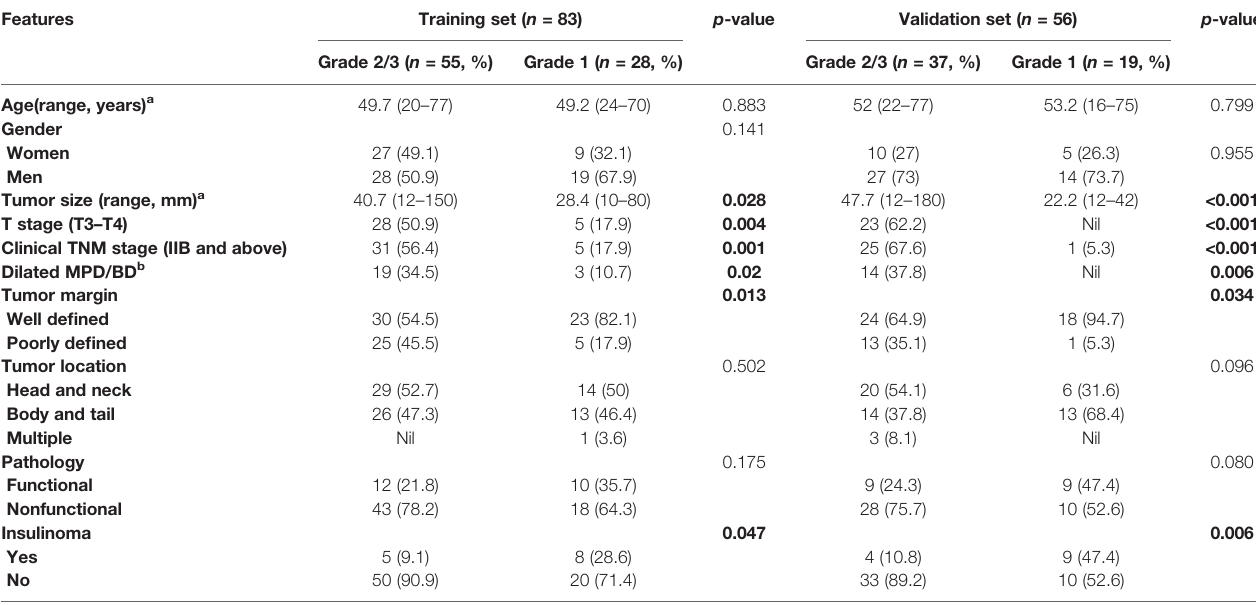
TABLE 1 | Comparison of patient and lesion features between grades 1 and 2/3 groups in training and validation sets. Features